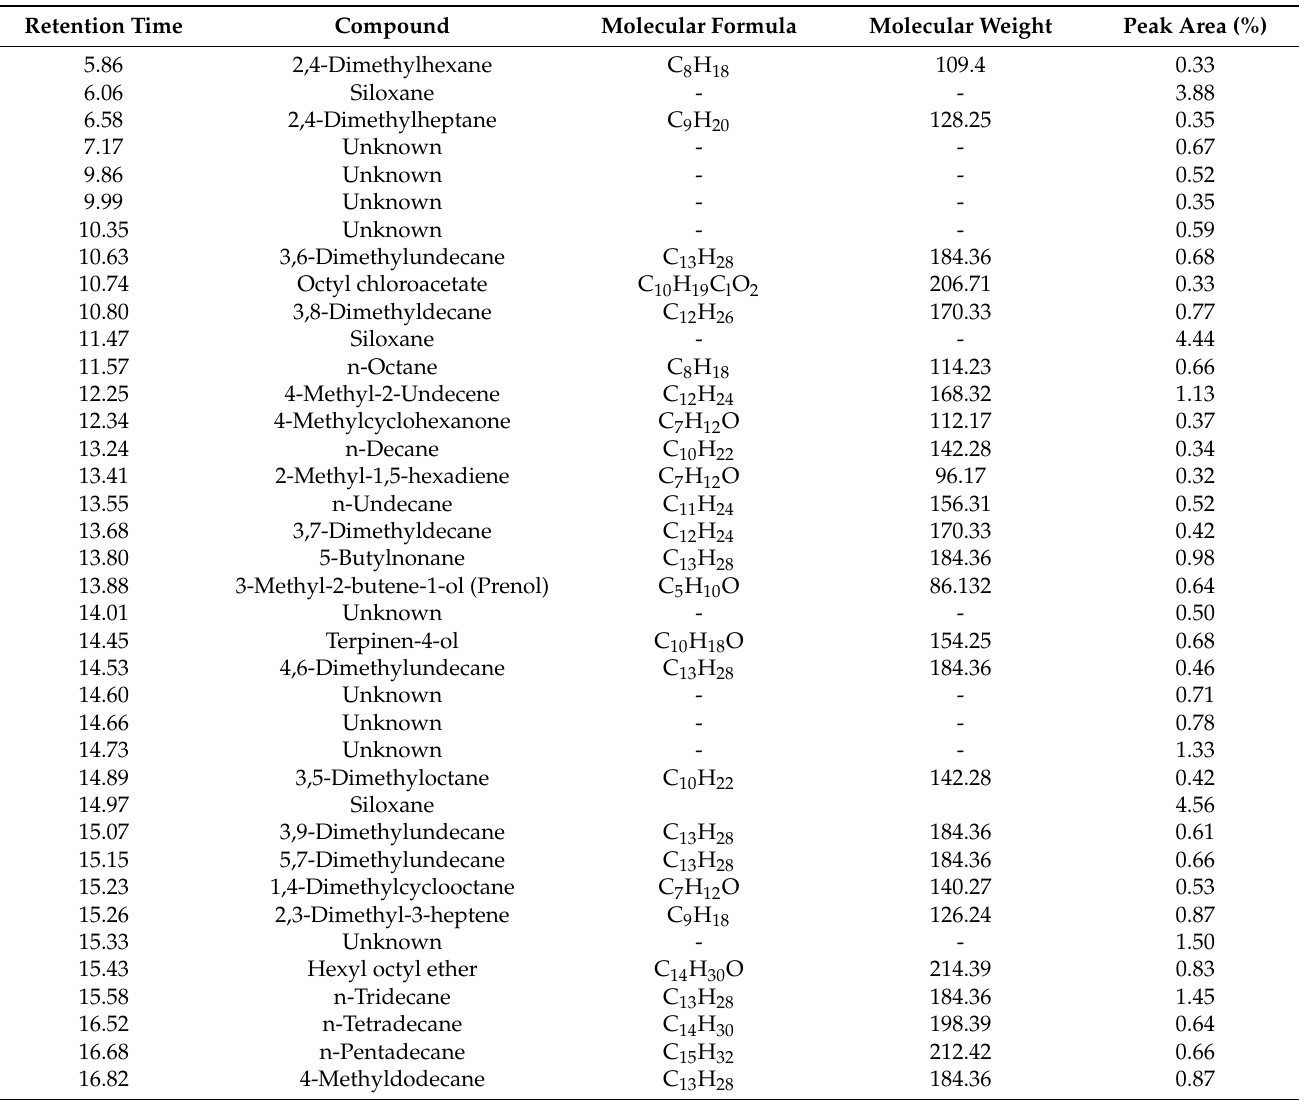
Figure 1. Representative gas chromatography (GC) chromatogram of the distillate. 2, 6, 10-trimethyldodecane (A; C 15 H 32 ; retention time, 17.65 min; peak area, 3.69%), 2, 6, 11, 15-tetramethylhexadecane (B; C 20 H 42 ; retention time, 20.58 min; peak area, 2.45%), n-heptadecane (C; C 17 H 36 ; retention time, 18.25 min; peak area, 2.02%), and n-docosane (D; C 22 H 46 ; retention time, 19.31 min; peak area, 1.64%) are identified as important ingredients. a–f: siloxane compounds (impurities derived from the column). Table 1. Compounds qualified in the distillate using gas chromatography/mass spectrometry.